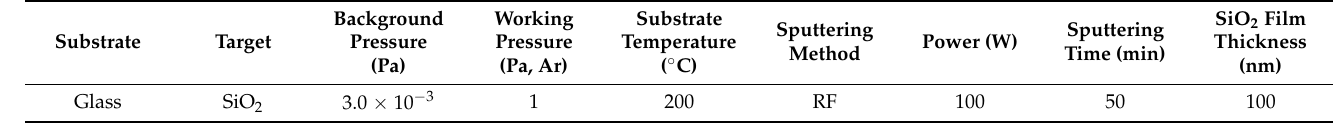
Table 2. Preparation parameters of the intermediate SiO 2 layer by RF magnetron